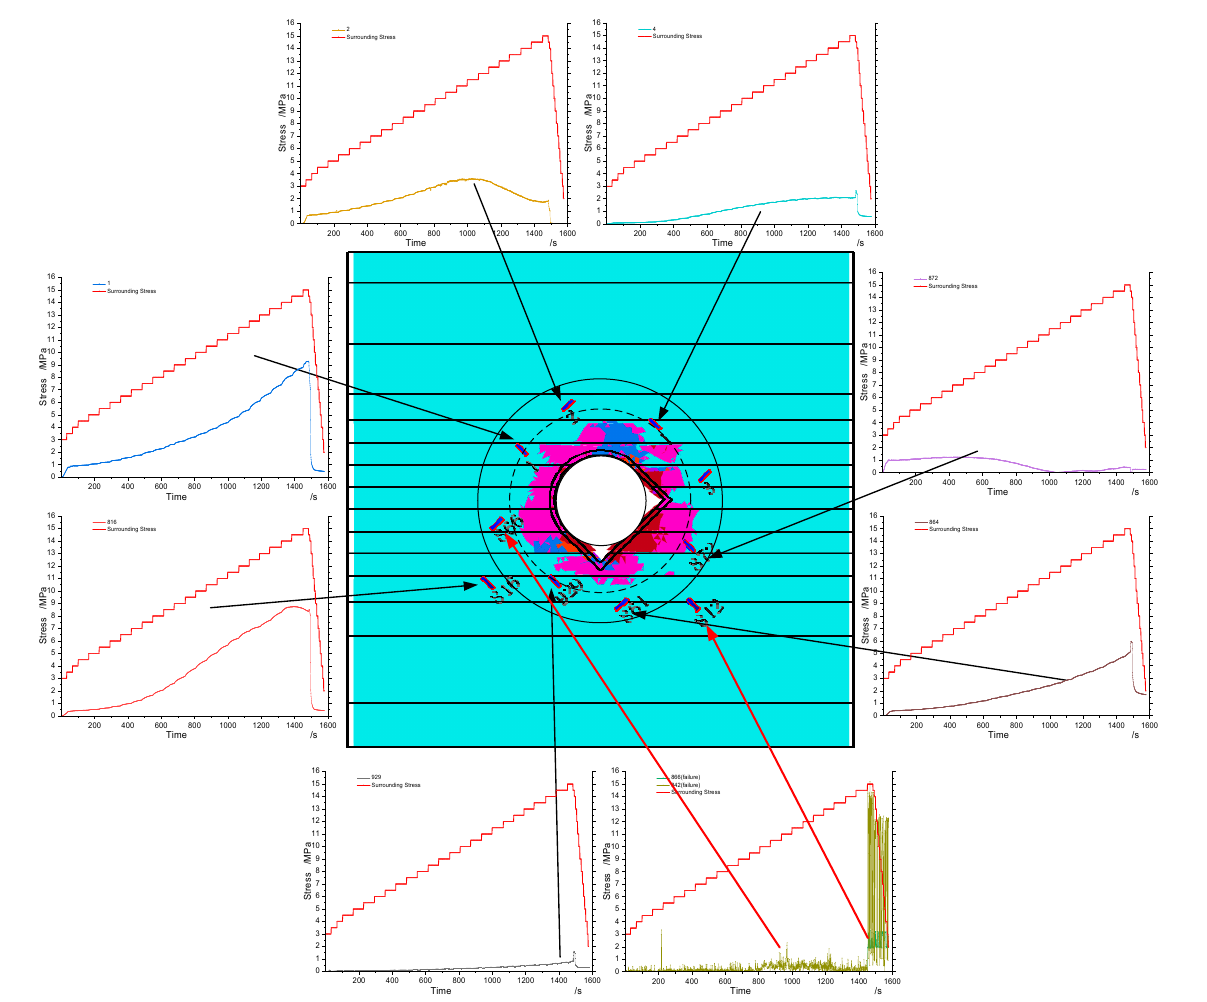
Figure 11. Plastic zone shape, stress measurement points, and stress distribution.